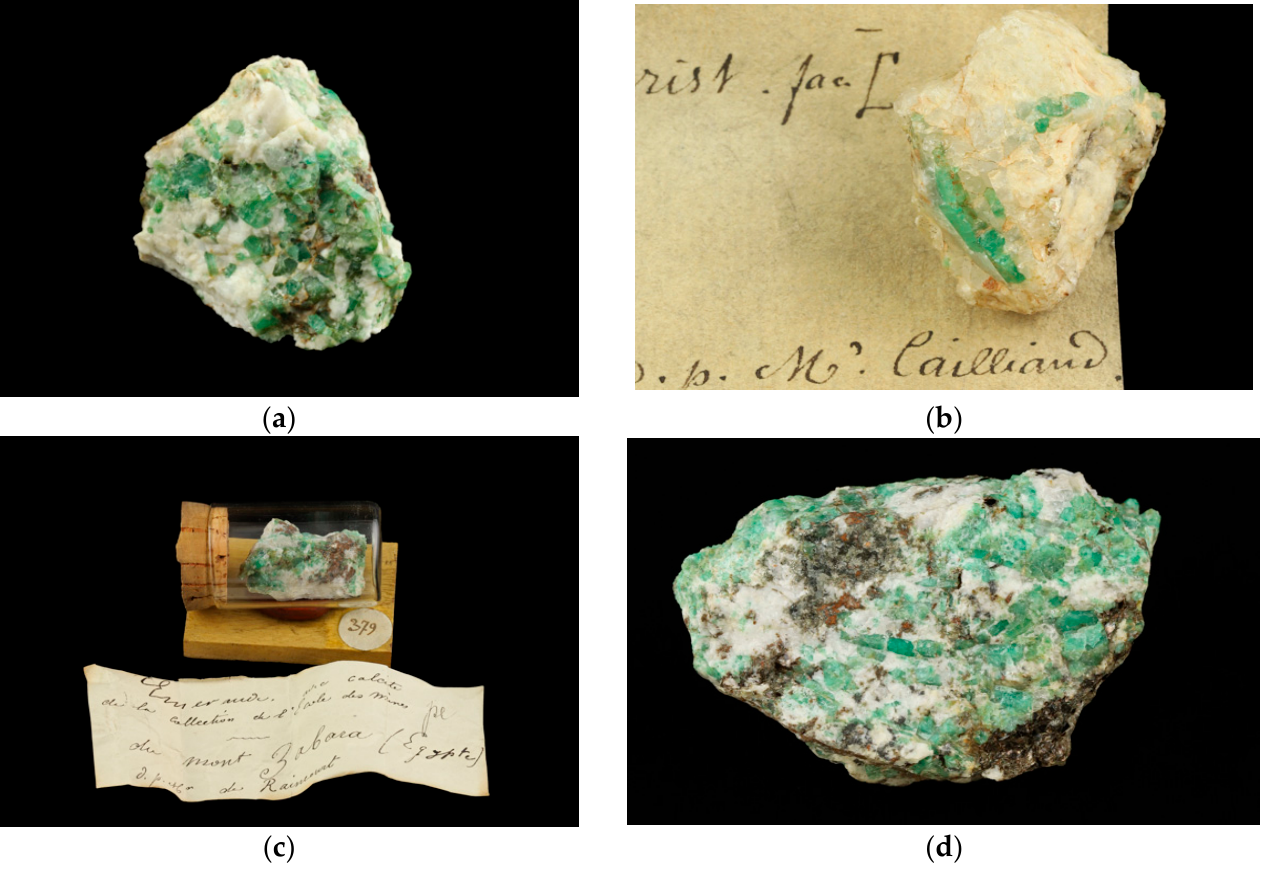
Figure 4. Macroscopic images of emerald samples included in the host rock from Ecole des Mines. ( a ) ENSMP 47849a26 (34.66 × 29.23 × 30.76 mm), ( b ) ENSMP 47849a27 (25.93 × 22.74 × 24.52 mm), ( c ) ENSMP 72,486 (31.83 × 16.83 × 21.50 mm), ( d ) ENSMP 13512_5 (85.6 × 57.53 × 50.08 mm).